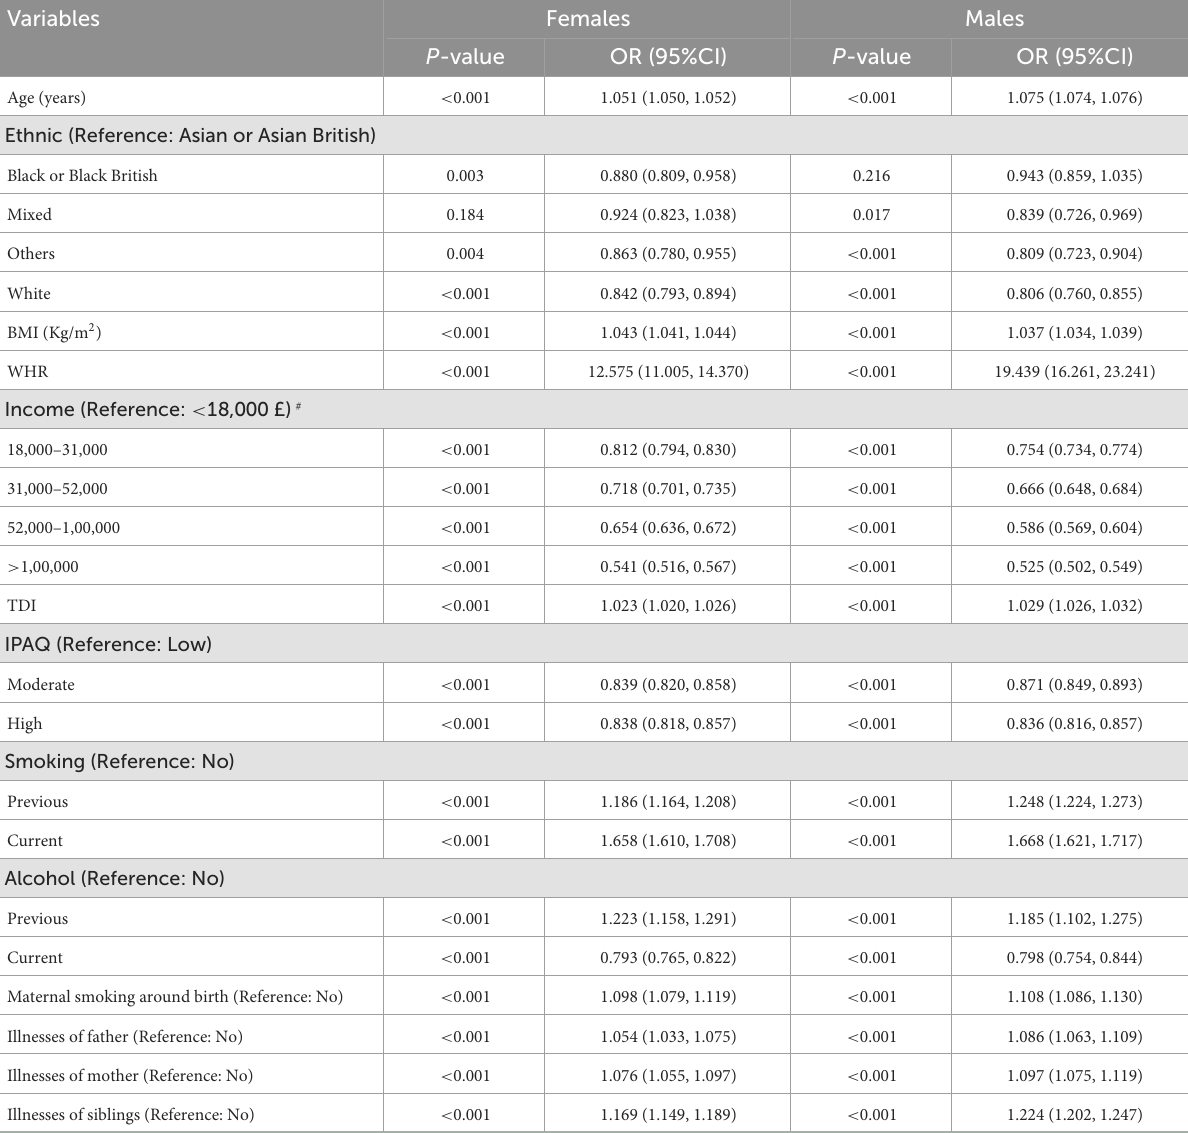
TABLE 4 Multivariate logistic regression analyzes of factors influencing CCI in females and males [Median (Q1, Q3)/ n (%)]. Variables Females